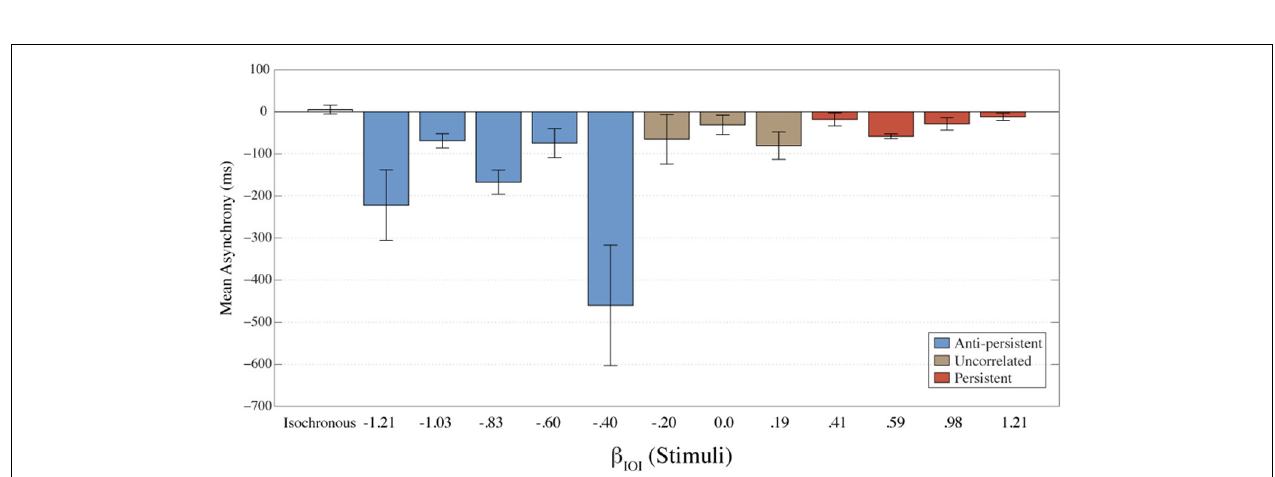
condition ( β IOI ). Error bars represent the standard error of the mean. The colors represent the amount of long-term correlation that the stimulus contained.